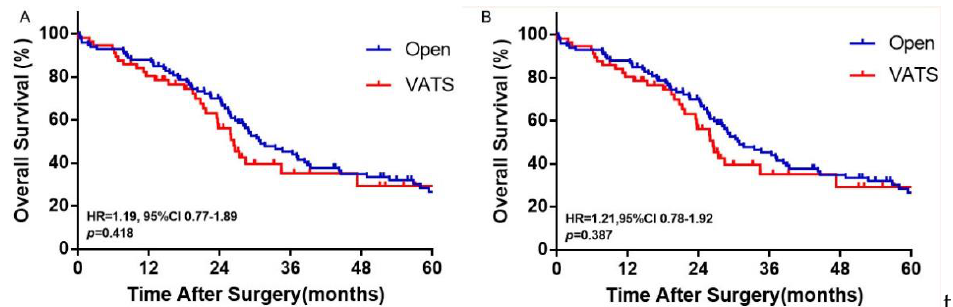
Figure 2. Overall survivals shown in Open and VATS pneumonectomy patients. ( A ) Overall survivals shown by Kaplan—Meier curves in Open and VATS pneumonectomy patients. ( B ) Cancer—specific survivals shown by Kaplan – Meier curves in Open and VATS pneumonectomy patients. During surgery, 20 patients (19.0%) were converted from VATS to Open thoracot- omy. Perioperative outcomes of the converted patients are shown in Table 3. Conversion